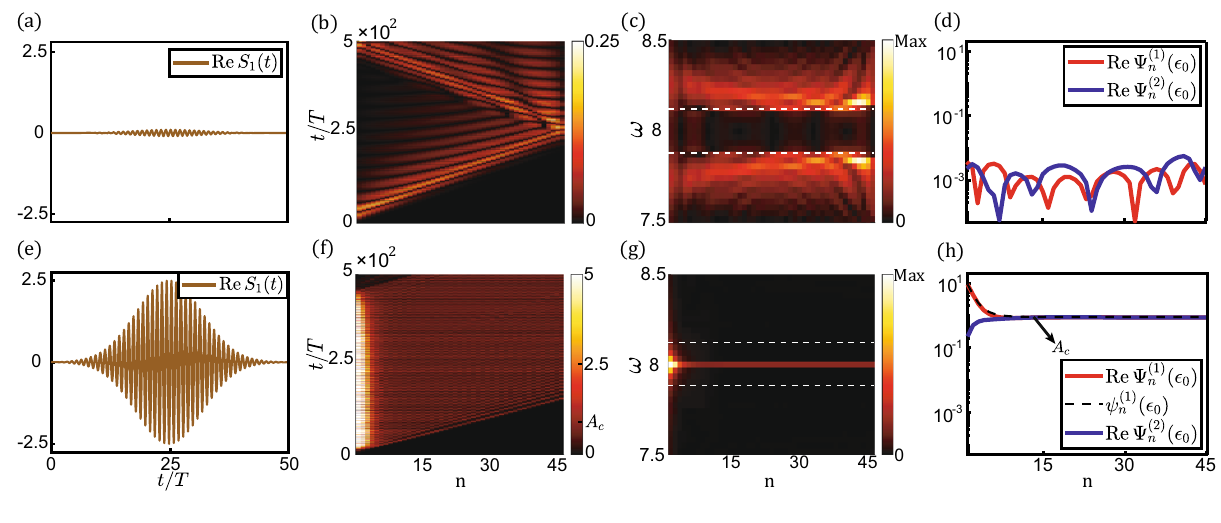
Fig. 3 Nonlinear boundary responses of the lattice subjected to N-to-T transition, where the parameters yield c 1 > c 2 and d 1 < d 2 . a – d and e – h exhibit lattice boundary excitations in the small-amplitude non-topological regime and the large-amplitude topological regime, respectively. The magnitudes of Gaussian signals are S = 0.1 in ( a ) and S = 2.5 in ( e ), respectively. ( b ) and ( f ), spatial-temporal pro fi les of j R e Ψ ð 1 Þ n ð t Þj for 45 sites. ( c ) and ( g ), frequency spectra of the lattice excitations for 45 sites. Fourier analysis is executed from 250 T to 500 T . White dashed lines encircle the linear band gap. ( d ) and ( h ), red and blue curves for the spatial distributions of the ω = ϵ 0 mode component of the lattice excitations. The analytic result of the anomalous topological modes ψ ð 1 Þ n ð ϵ 0 Þ is captured by the black dashed curve in ( h ).